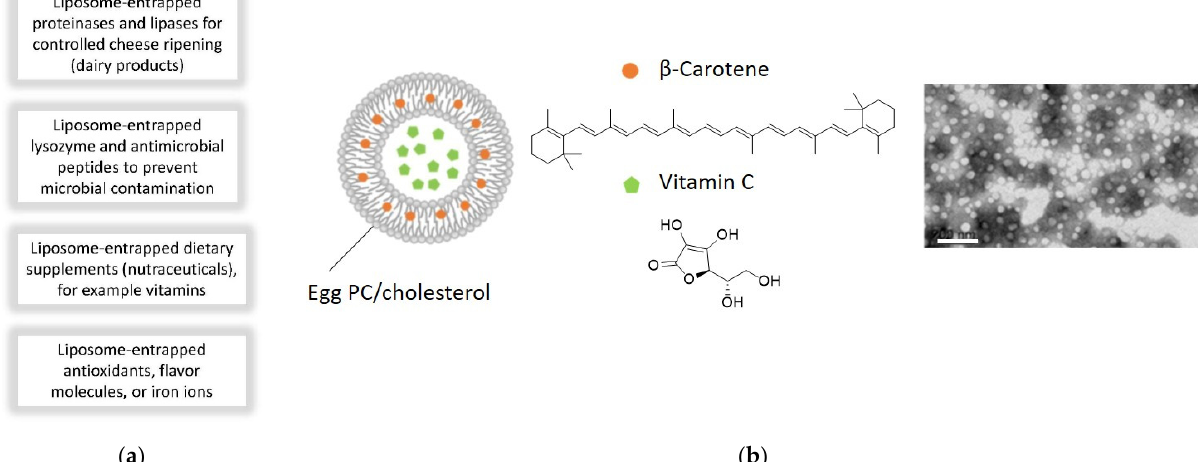
Figure 36. Application of lipid vesicles in food processing and nutrition. ( a ) Some of the areas of food technology and nutrition where the use of liposomes has been explored or where liposome-based products are used commercially as food supplements; see [488–490,496,500]. ( b ) Illustration of lipid vesicles that were co-loaded with water-soluble (vitamin C) as well as membrane-soluble molecules ( β -carotene) and of a negatively stained TEM image of the vesicles prepared (bar: 200 nm), as published by Liu et al. (2020) [499]. A mixture of egg PC and cholesterol was used as vesicle membrane- forming amphiphiles. Sonication was applied for lipid dispersion and vesicle size reduction [499]. The reported size of the vesicles obtained was about 250 nm (as determined by dynamic light scattering), larger than the objects seen in the TEM image obtained from dried samples (stained with sodium phosphotungstate). Reproduced with permission from [499], Elsevier, 2020.